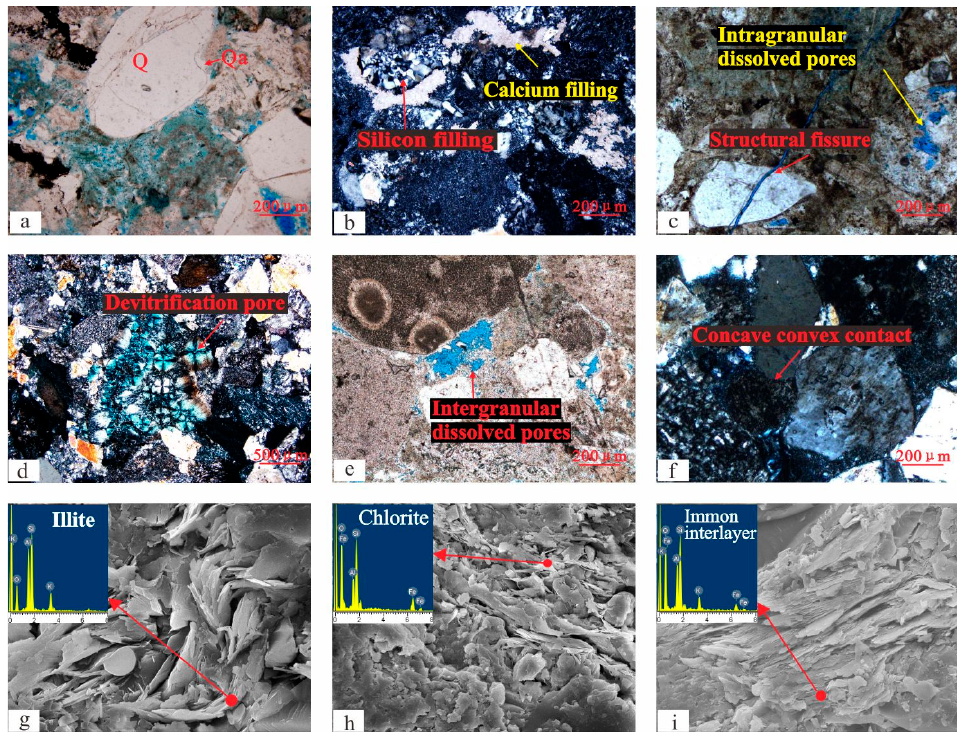
Figure 8. Diagenesis stage of sedimentary pyroclastic rocks in K 1 y 2 , YFD (the data of R o from Jilin Oilfield).